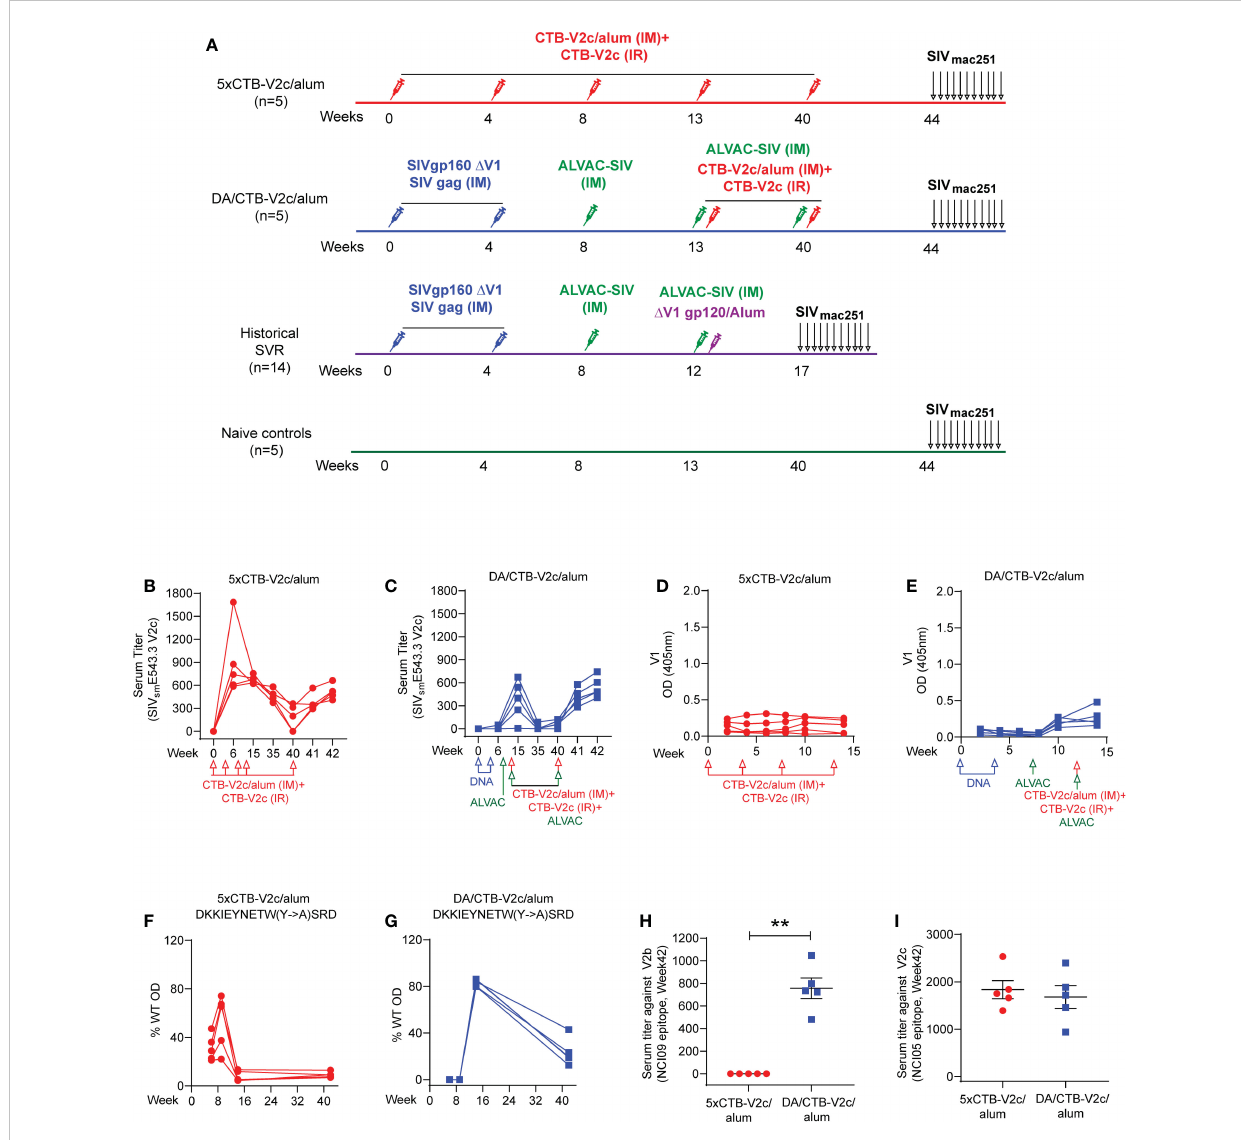
FIGURE 2 CTB-V2c vaccine induces V2 speci fi c immune responses in macaque model. (A) Schematic vaccine study design in macaque model. Fifteen rhesus macaques were subdivided into three groups: 5xCTB-V2c/alum vaccine (n=5), DA/CTB-V2c/alum vaccine (n=5), and controls (n=5). A historical standard vaccine regimen (SVR) was added (n=14) for immune response comparison. Five animals in the 5xCTB-V2c/alum vaccine group were vaccinated with 0.5 mg of CTB-V2c in alum (IM) and 1 mg of CTB-V2c (IR) on weeks 0, 4, 8, 13 and 40. Five animals in the DA/CTB-V2c/alum vaccine group were primed with 2x D V1DNAgp160+p57 Gag weeks 0, 4; and boosted with ALVAC-SIV encoding env , gag , and pol on week 8 and ALVAC-SIV+ CTB-V2c in alum (IM)+CTB-V2c (IR) on week 13 and 40. Beginning at week 44, protective ef fi cacy against SIV mac251 was assessed by subjecting all animals to up to 11 weekly intravaginal viral exposures (arrows) until infection was con fi rmed. (B, C) Anti-V2c serum titers were detected in 5xCTB-V2c/alum and DA/ CTB-V2c/alum group. (D, E) V1-speci fi c IgG binding in macaques after immunization with the 5xCTB-V2c/alum vaccine or DA/CTB-V2c/alum vaccine. (F, G) Percent of serum antibody binding to point mutants in the WT-V2c probe peptide by the two vaccinated group animals. Sequences with mutations indicated displayed above each graph and each line represents one macaque. (H, I) Comparison of s erum antibody titer against V2b peptide 115 and V2c peptide 150 in 5xCTB-V2c/alum or DA/CTB-V2c/alum vaccinated animals. Red circles indicate 5xCTB-V2c/alum vaccinated macaque group, blue squares indicate DA/CTB-V2c/alum vaccinated macaque group. Data shown in (H, I) were analyzed with the Mann-Whitney U test. Horizontal and vertical bars denote mean and SD, respectively. **p <